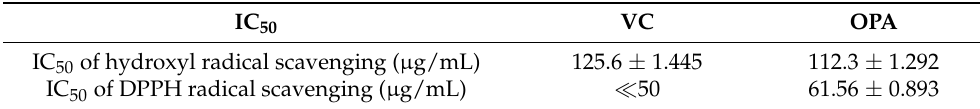
Table 4. IC 50 values of hydroxyl radical scavenging and DPPH radical scavenging.